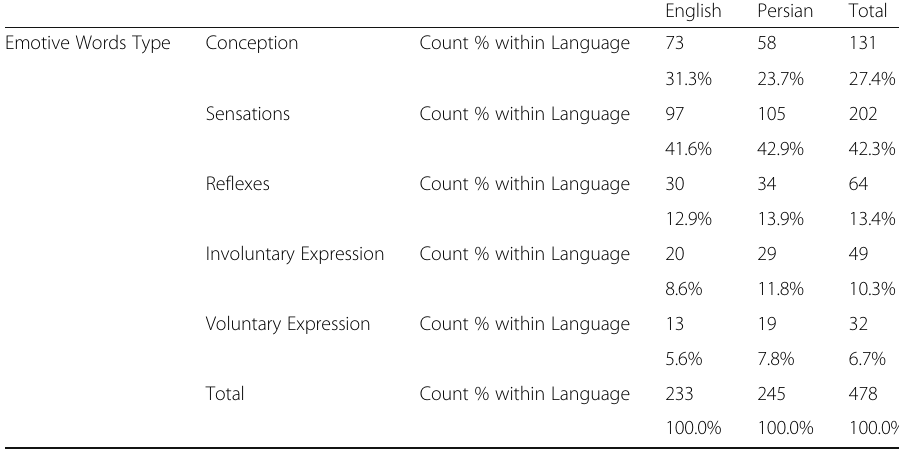
Table 4 Cross Tabulation Results for Different Token of EWs in English and Persian Short Stories